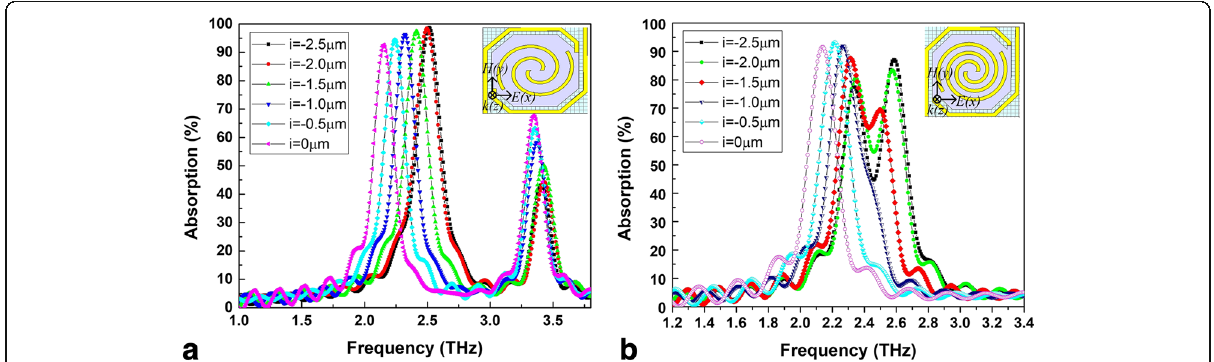
Fig. 5 THz wave absorption curves of spiral-type antenna-coupled micro-bridge structures with two separate linear antennas on the bridge legs when n = 1.1 ( a ) and n = 1.6 ( b ) for different linear antenna